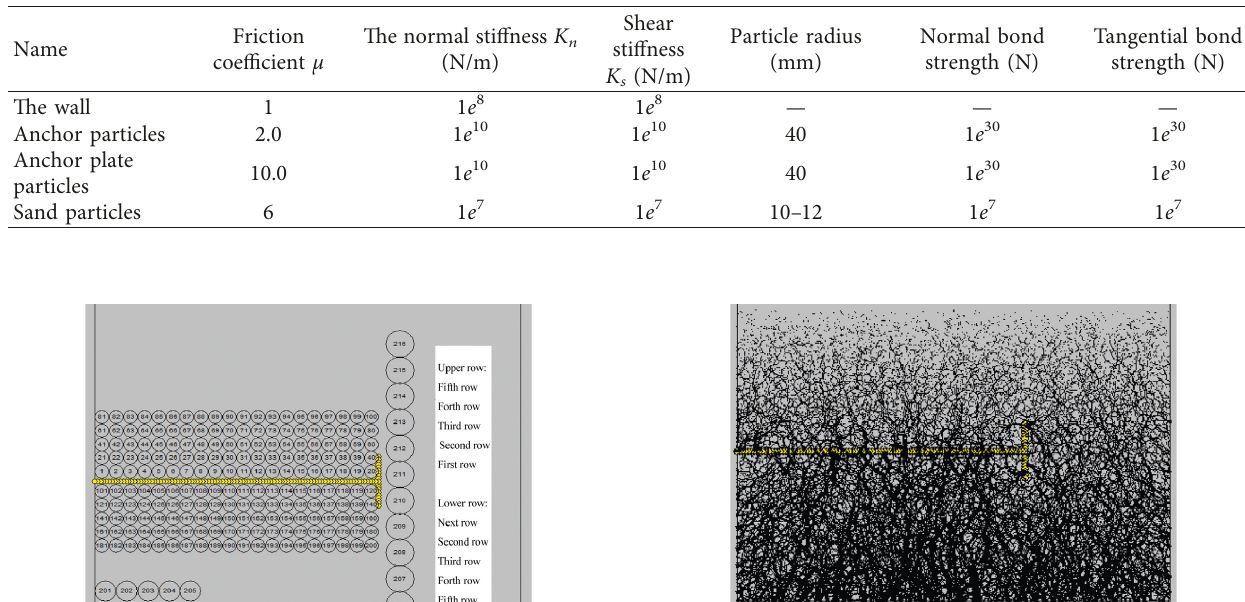
Table 2: Mechanical parameters of the soil particles.